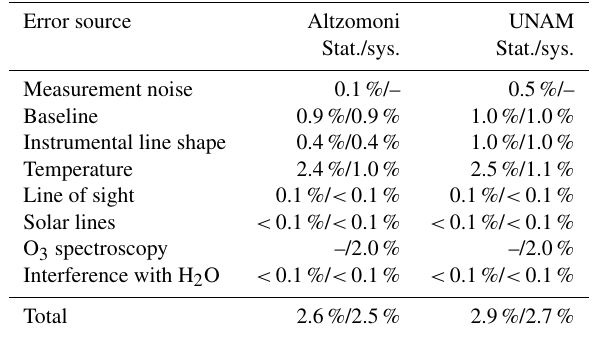
Table 2. Estimated errors for the total column abundances of O 3 remote sensing data obtained at Altzomoni and